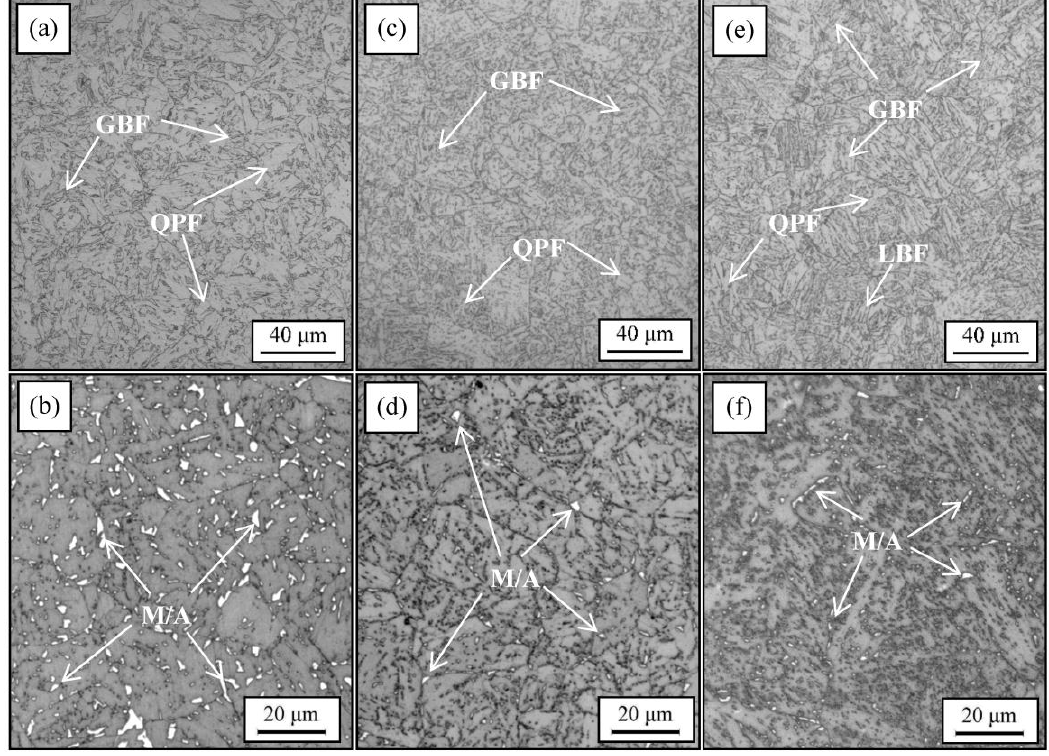
Figure 4. Optical micrographs of 4% Nital solution and Lepera’s reagent etched samples of: ( a , b ) 5 °C/s; ( c , d ) 15 °C/s; and ( e , f ) 20 °C/s. QPF—quasi-polygonal ferrite, GBF—granular bainite ferrite, LBF—Lath bainite ferrite, M/A—Martensite/austenite constituent.